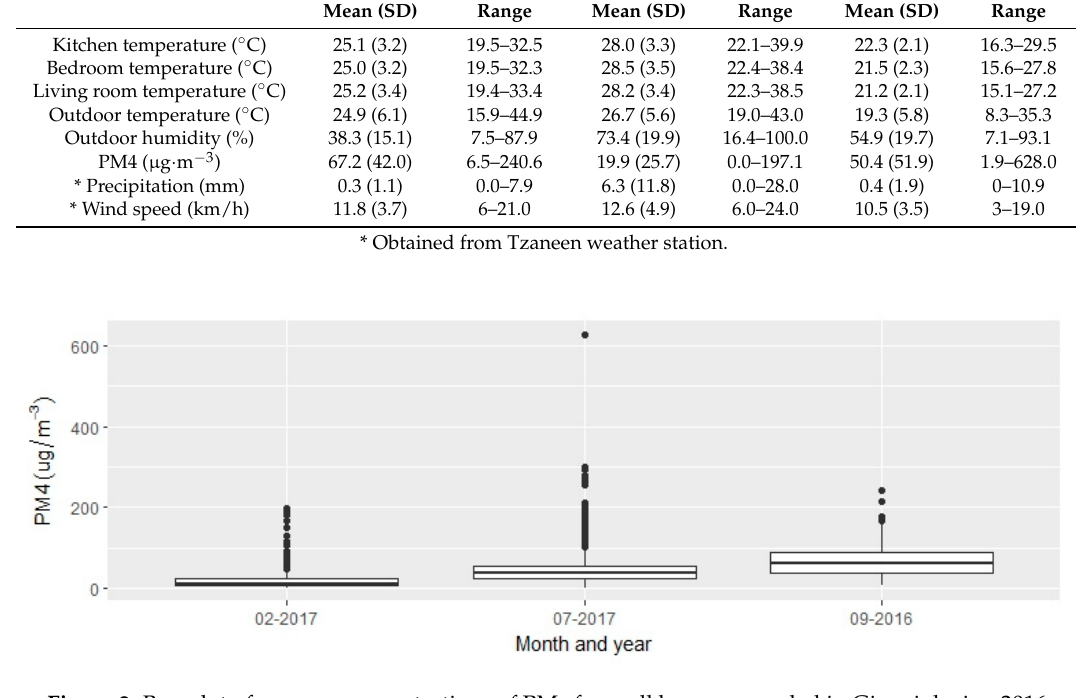
Figure 2. Box plot of average concentrations of PM 4 from all houses sampled in Giyani during 2016 and 2017 ( line : median; interquartile range box : middle 50% of the data; whiskers extending from either end of the box : ranges for the bottom and top 25% of the data values; solid black dots : outliers).